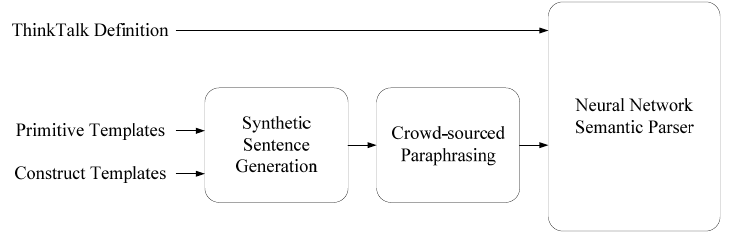
Figure 2. GENIE working flow.